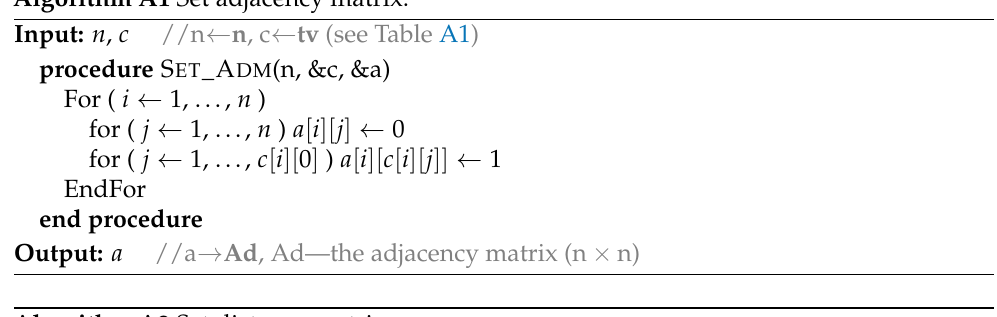
Algorithm A2 Set distance matrix.